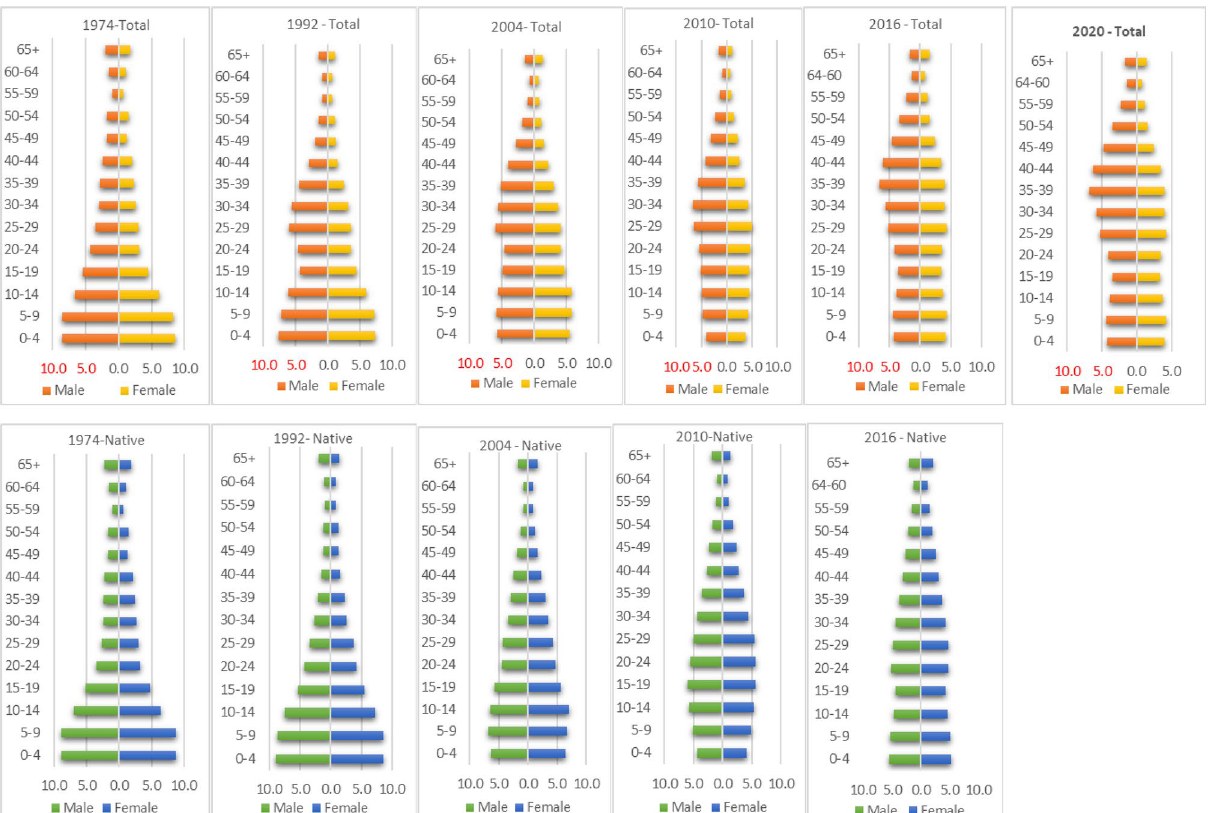
Figure 3. Age structural changes in the total population and the native population, over the